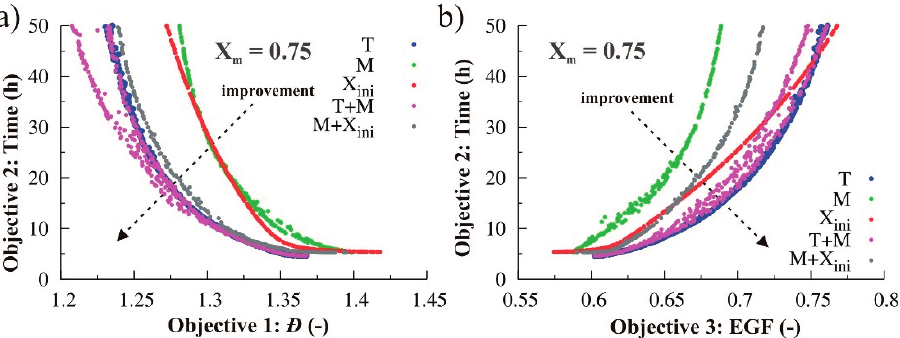
Figure 10. Comparison between multi-objective optimization (MOO) results of NMP of styrene for the different individual optimization pathways: temperature program ( T ) (blue; Figure 7a), fed-batch addition of monomer ( M ) (green; Figure 8a), excess initial nitroxide ( X ini ) (red; Figure 9a), the synergetic combination of temperature program and fed-batch monomer addition (purple), the synergetic combination of fed-batch addition of monomer and excess initial nitroxide (grey) ( a ) projection for objective 1 ( Ð ) and objective 2 (time), and ( b ) projection for objective 3 (EGF) and objective 2